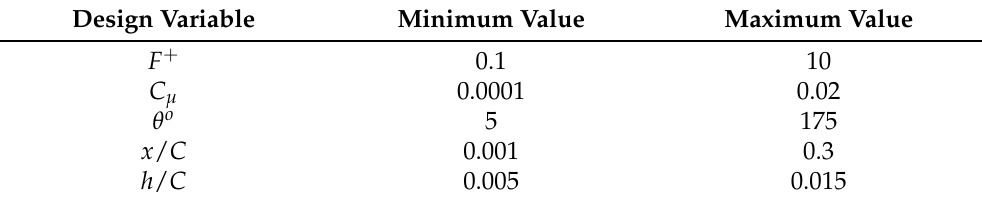
Table 3. Active Flow Control design variables and their evaluation